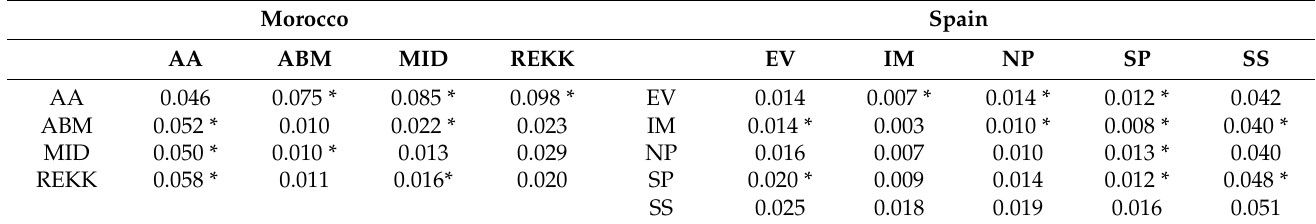
Table 3. Matrix of pairwise F ST values between regions in Morocco (Anti Atlas, AA; Ain Bni Mathar, ABM; Midelt, MID; and Plateau of Rekkam, REKK) and Spain (Ebro Valley, EV; Iberian Mountains, IM; Northern Plateau, NP; Southern Plateau, SP; and Southern Spain, SS). F ST values below diagonal correspond to comparisons in the recent past period and above diagonal in the current